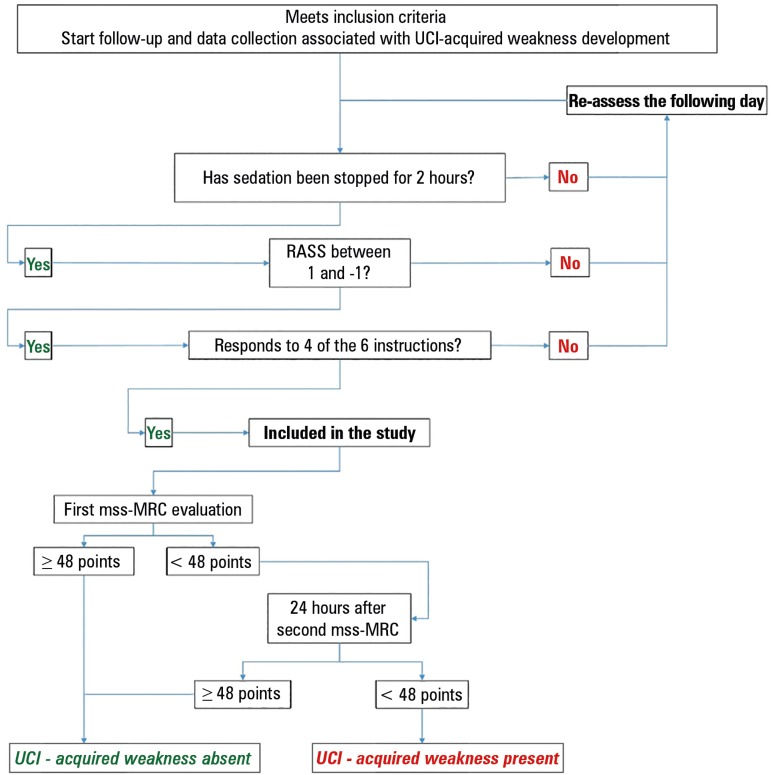
Flowchart of the procedures performed in this study.ICU - intensive care unit; mss-MRC - muscular strength scale of the
Medical Research Council.